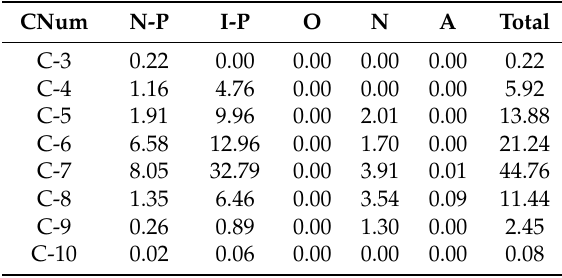
Table 6. The product of light naphtha Isomerization (100